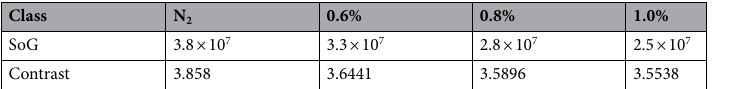
Table 2. Parameters of NO 2 at different concentrations (collected by single-band light).